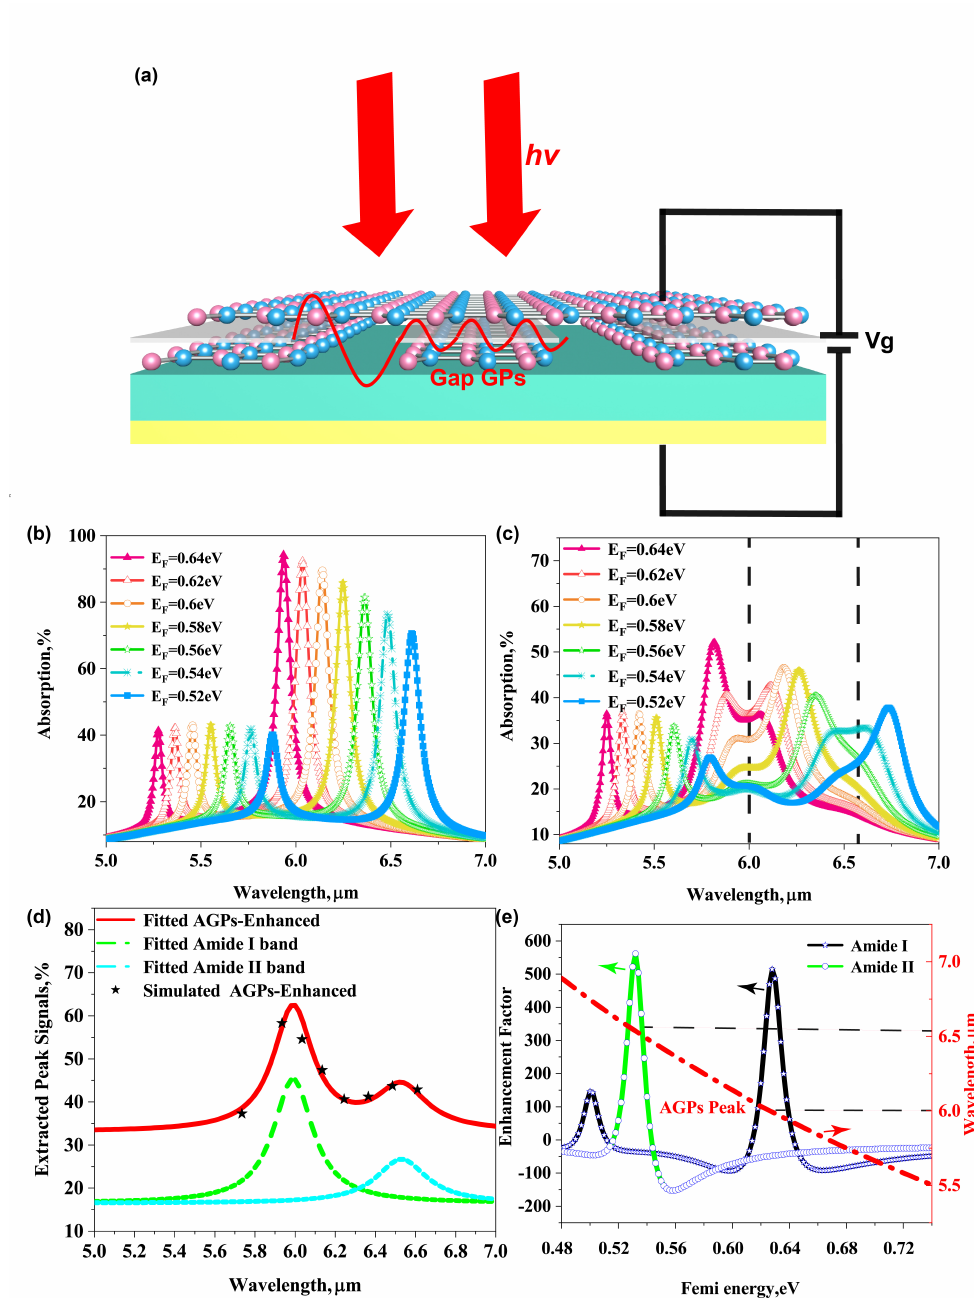
Figure 5. ( a ) Conceptual view of the bilayer AGPs mid-IR tunable biosensor. ( b ) Extinction spectra of the bilayer AGPs biosensor by varying E F of doping graphene. ( c ) Extinction spectra of the biosensor with 3 nm protein in nano-gap by varying E F . The dashed lines show the positions of the absorption band of molecules. ( d ) Lorentz fitted molecular absorption enhanced by AGPs. ( e ) The calculation for enhancement of the molecular absorption at amide I and II bands at varying E F